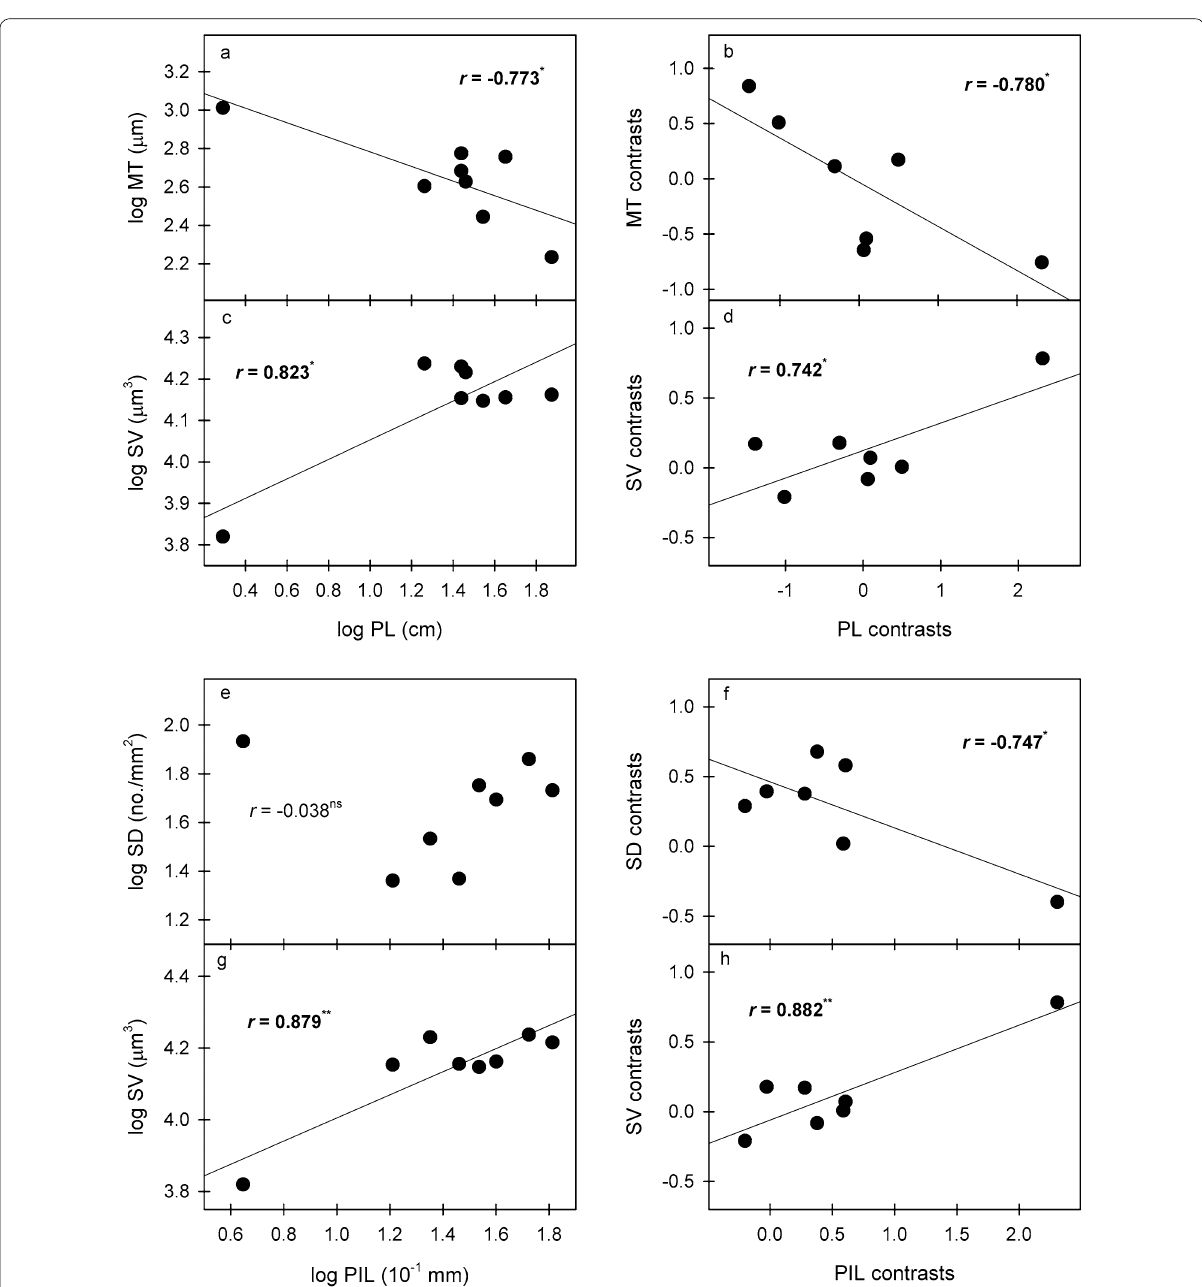
Fig. 3 Significant correlations of species mean values and phylogenetically independent contrasts (PICs) between pseudobulb and its internode length and leaf traits. * p < 0.05; ** p < 0.01. MT mesophyll thickness, SD stomatal density, SV stomatal volume, PL pseudobulb length, PIL pseudobulb internode